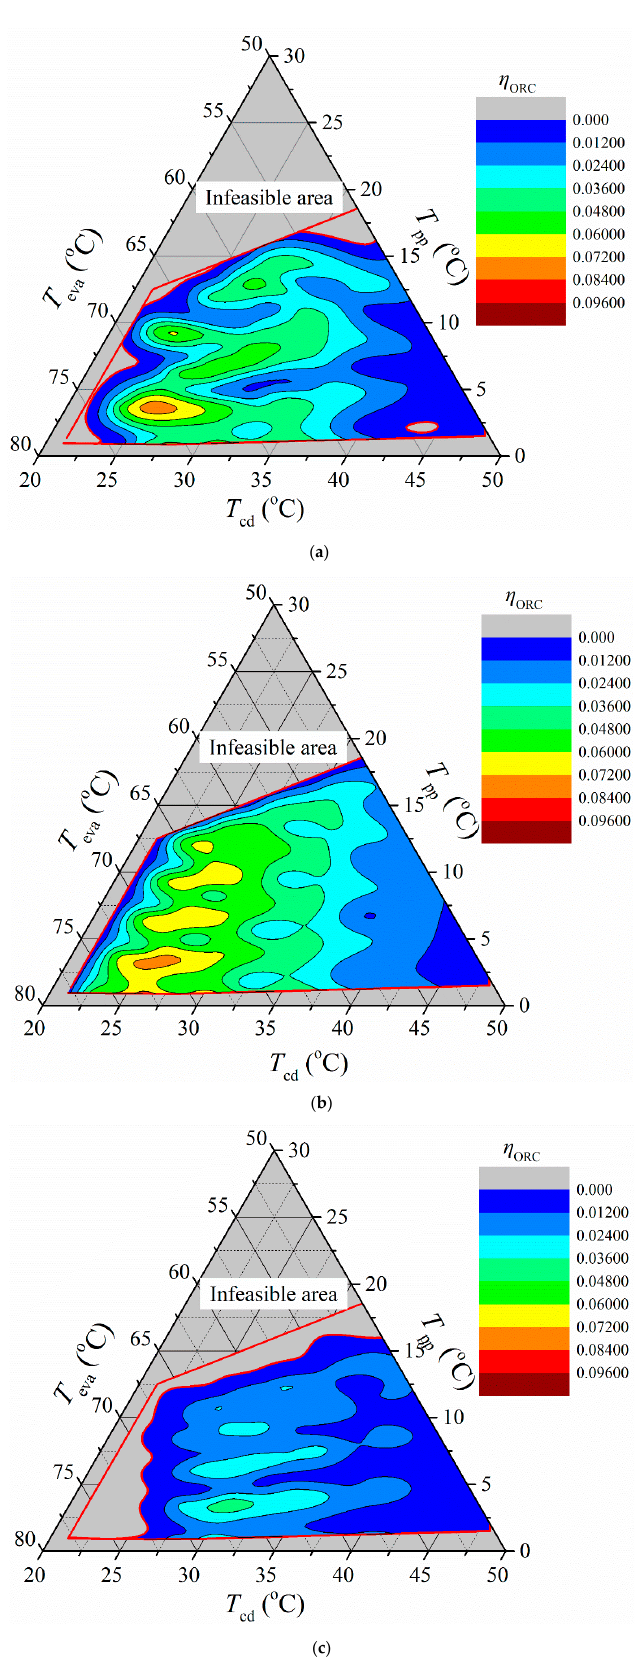
Figure 4. Operation maps and boundary variations of ORC thermal efficiency: ( a ) 𝑚(cid:4662) (cid:2933)(cid:2916) ∈ [0.029kg/s,0.120kg/s] ; ( b ) 𝑚(cid:4662) (cid:2933)(cid:2916) = 0.041kg/s ; ( c ) 𝑚(cid:4662) (cid:2933)(cid:2916) = 0.12kg/s .